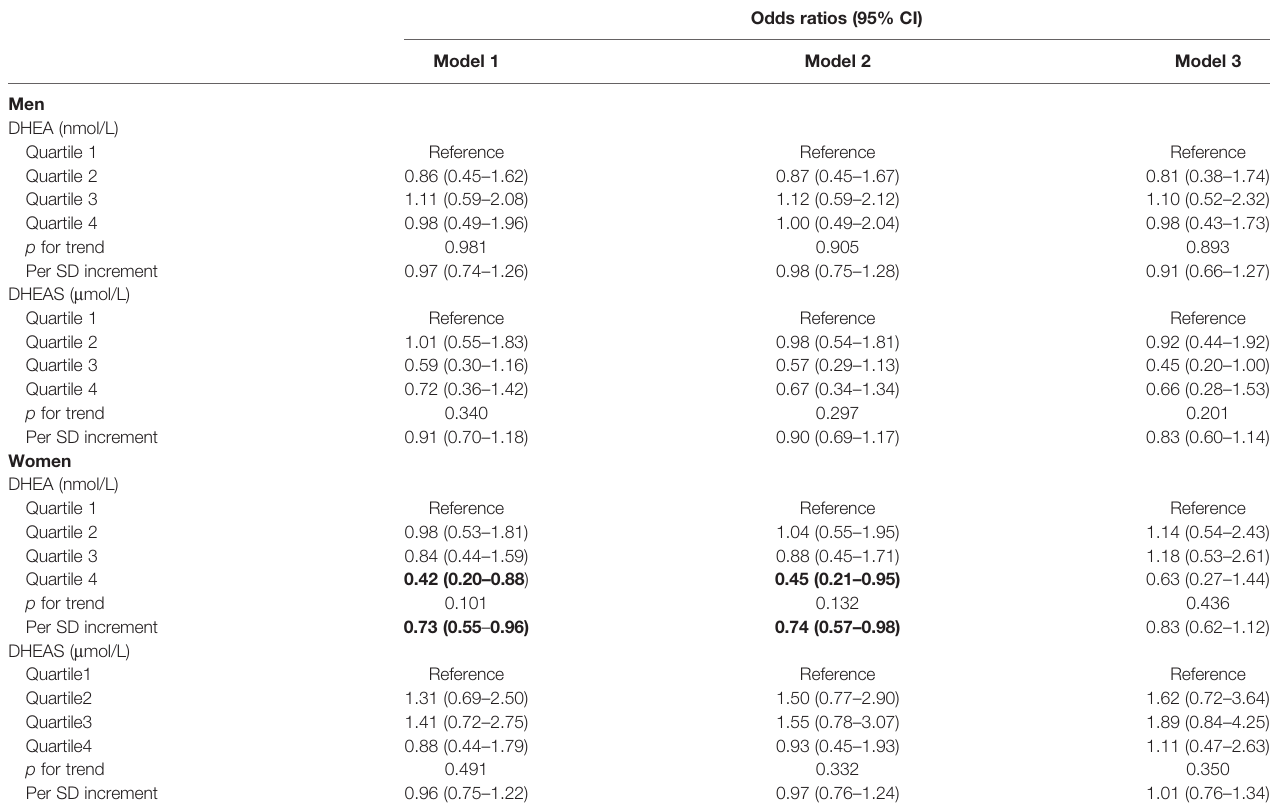
TABLE 3 | Odds ratios of stroke by different DHEA and DHEAS status in patients with type 2 diabetes mellitus.